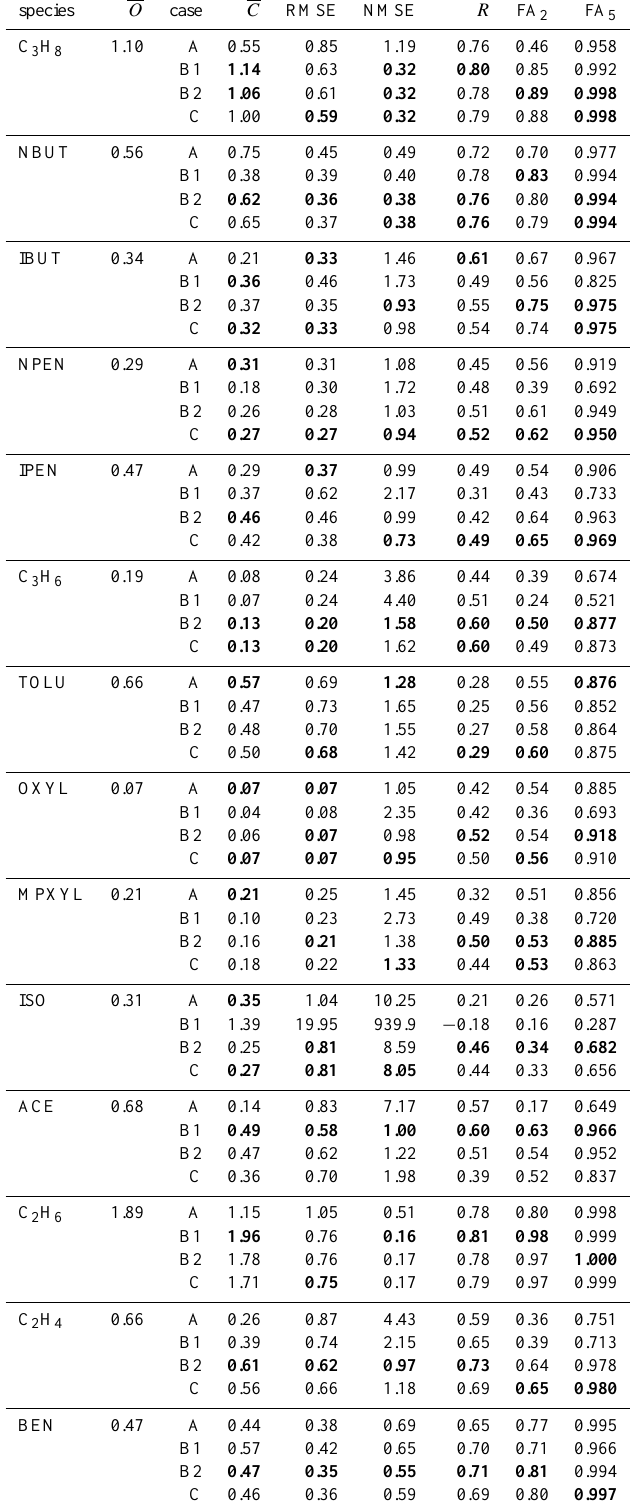
Table 8. Scores of the forecast test (year 2006) from the comparison of the observations and the simulated concentrations for four simula- tions: case A, case B1, case B2 and case C. The means and the RMSEs are in µgm − 3 . Bold numbers correspond to the best agreement with